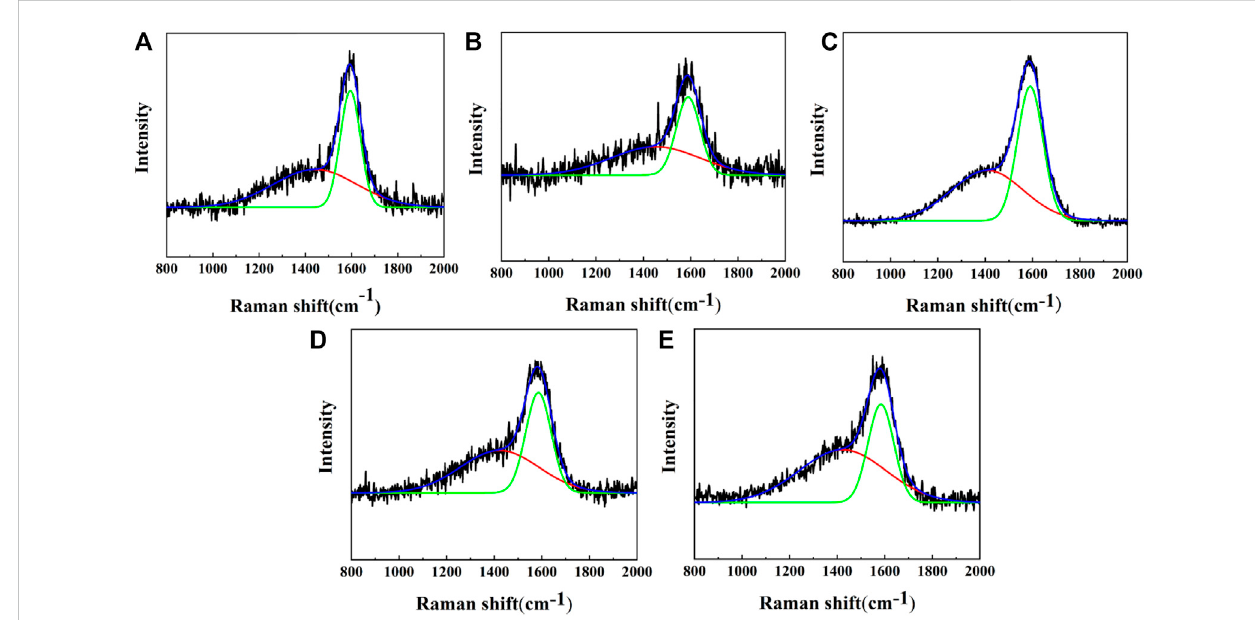
FIGURE 1 Raman results of PI surfaces treated by carbon plasma with different graphite target currents: (A) 1.0A; (B) 1.5A; (C) 2.0A; (D) 2.5A; (E) 3.0A.